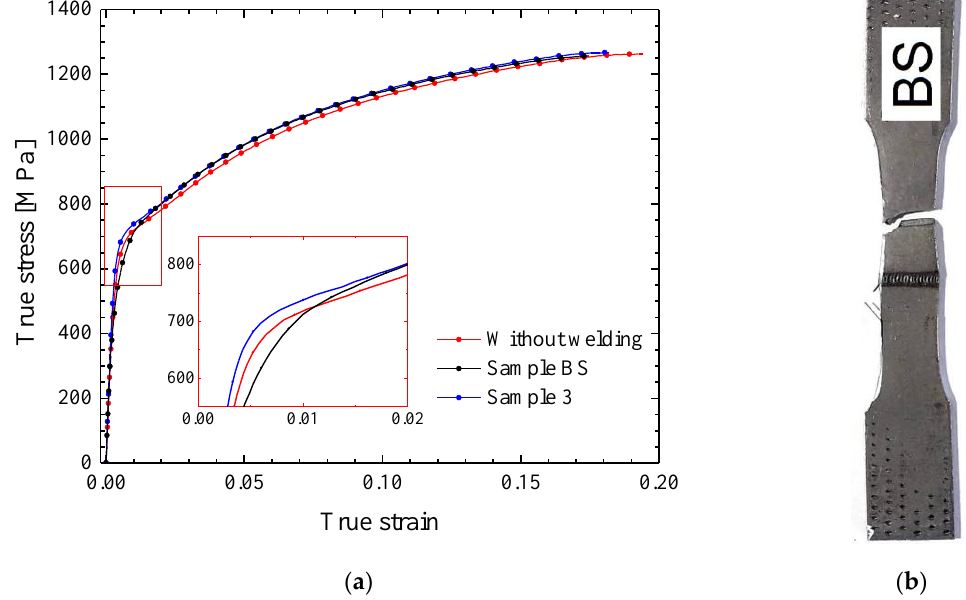
Figure 8. ( a )True stress vs. strain curve for the selected set of the parameters to weld on both sides and ( b ) uniaxial tensile test carried out until the fracture for Sample BS.